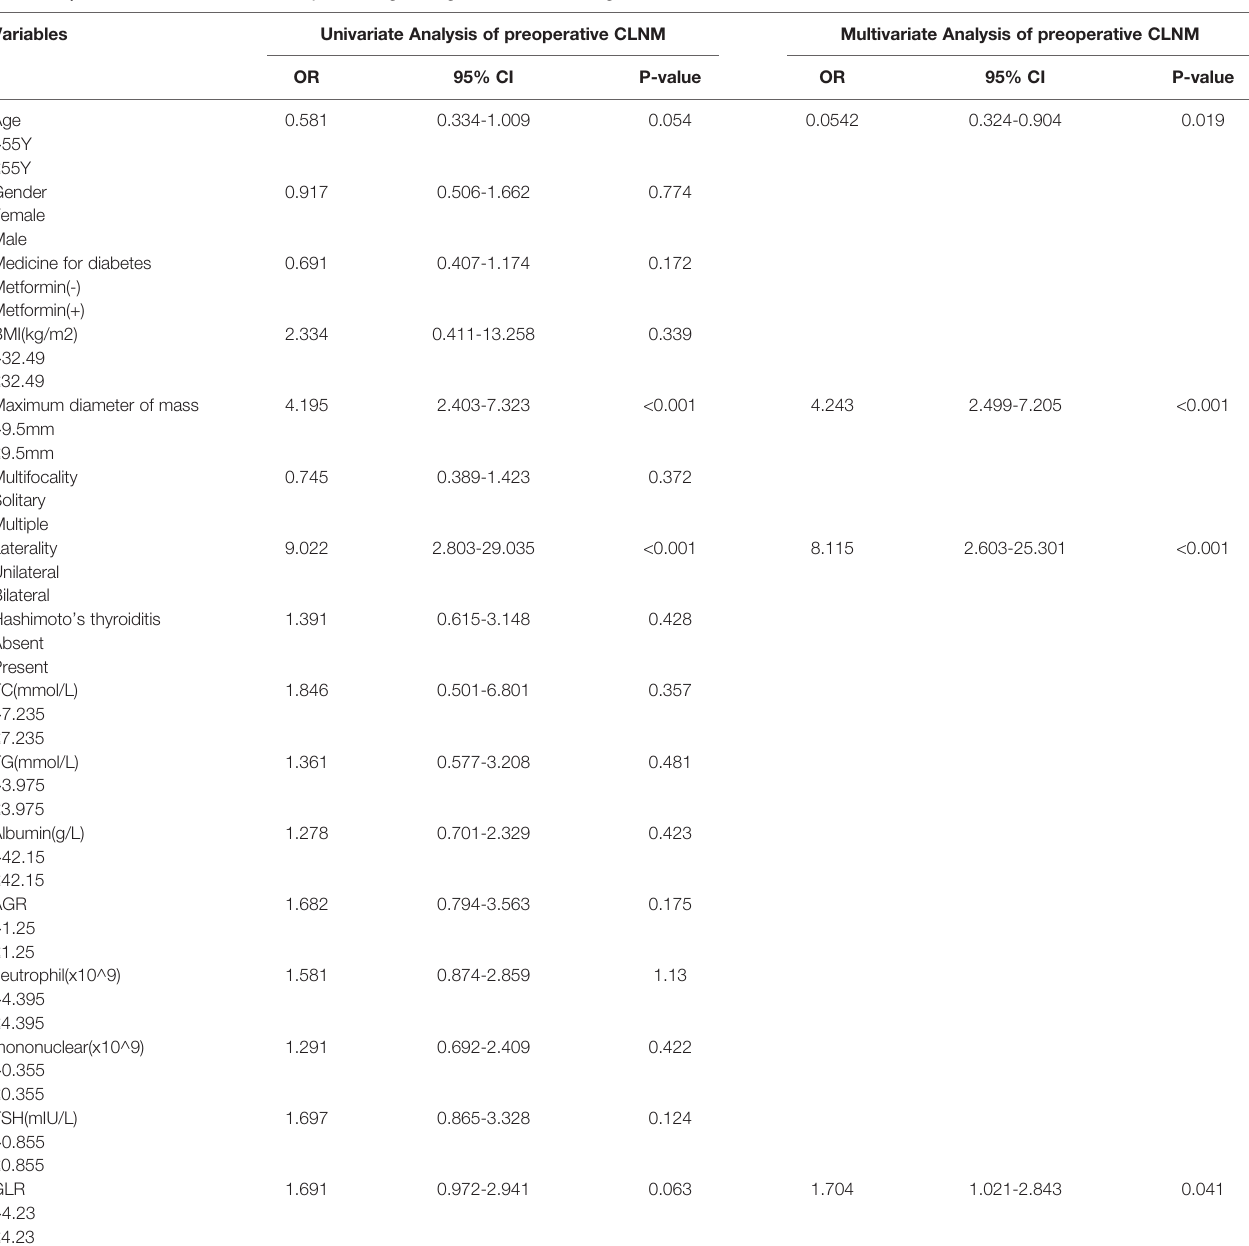
TABLE 3 | Univariate and multivariate analyses for logistic regression in the training data